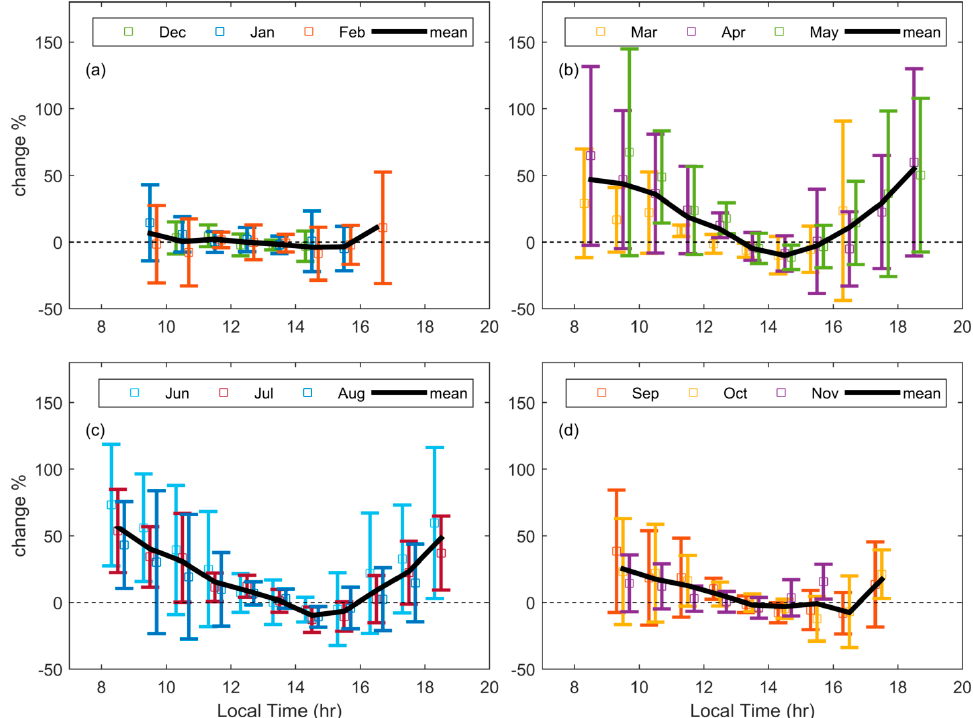
Figure 5. Average diurnal variability of the monthly mean AAOD at 340 nm for ( a ) winter, ( b ) spring, ( c ) summer, and ( d ) autumn. The mean of the three months of each season is represented by the black thick line. Error bars represent the standard deviation for the monthly averages of each hourly value.